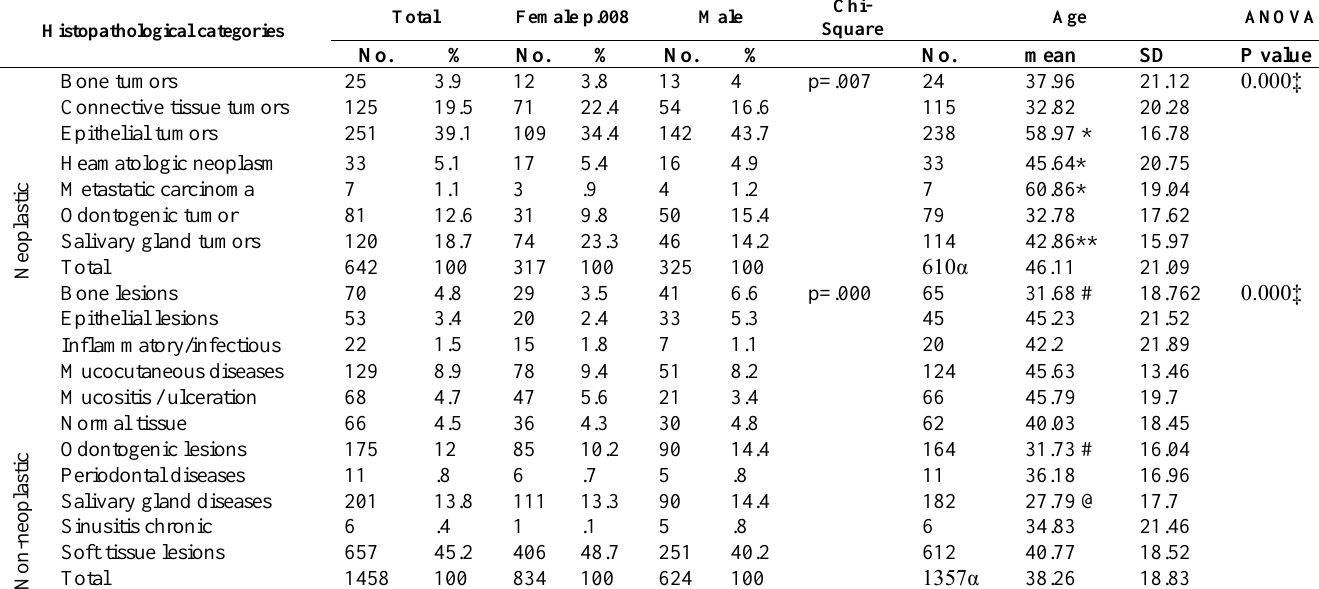
Table 1: Total 2100 oral and maxillofacial surgical lesions categorized into major histopathological neoplastic and non-neoplastic lesions in relation to gender and age